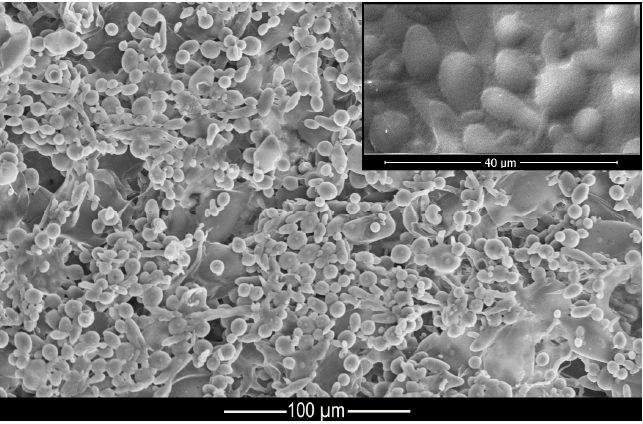
Figure 3. Micrograph of methyl salicylate microcapsules.